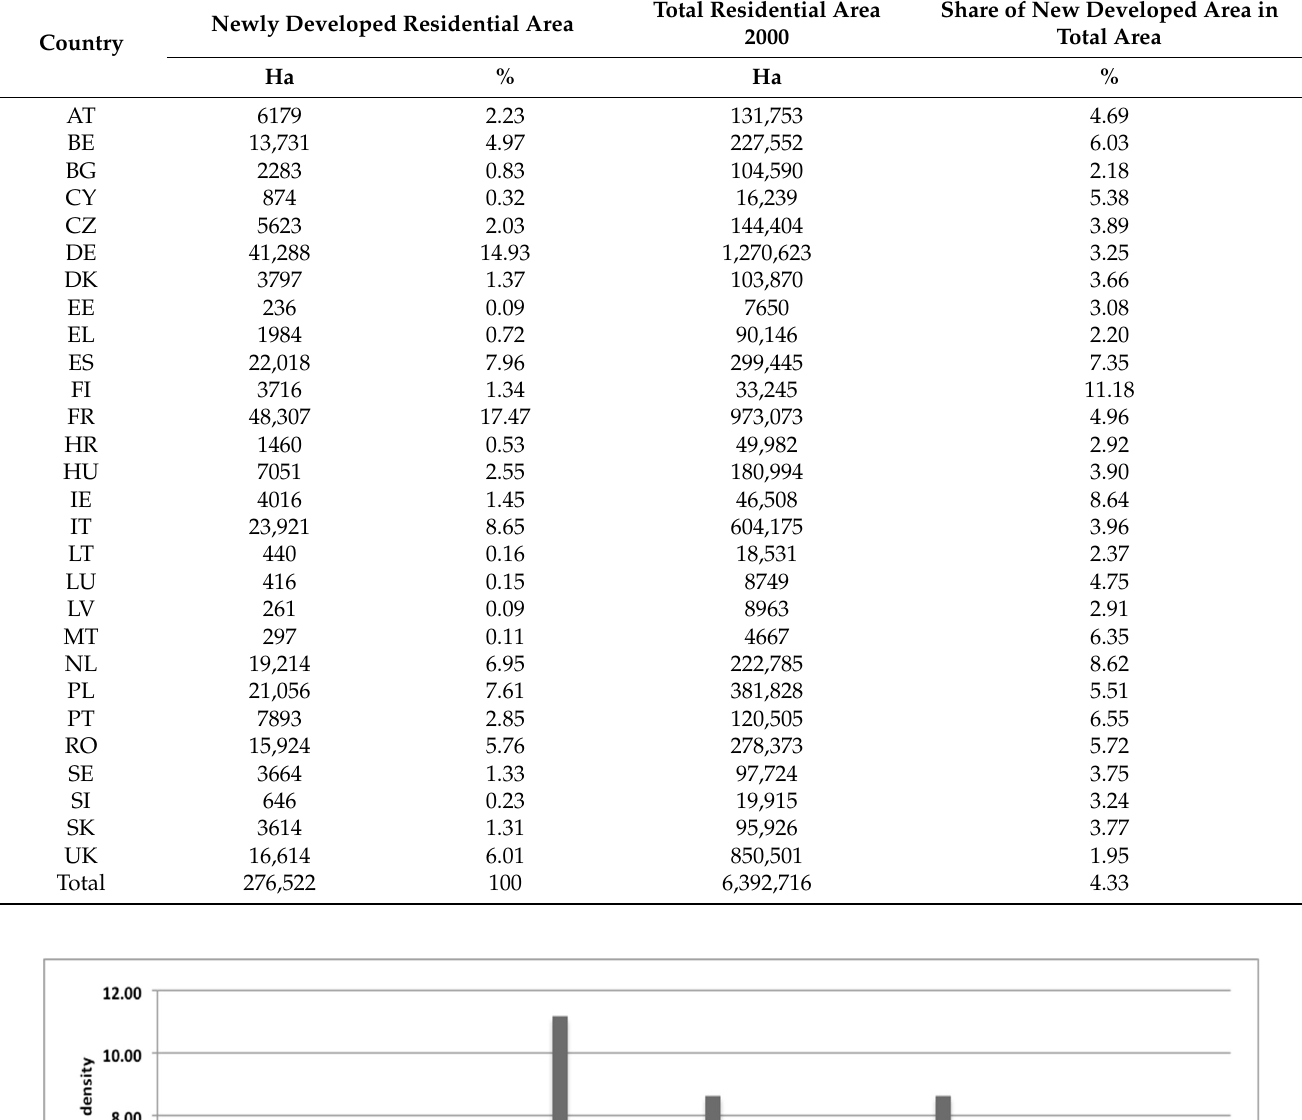
Table 2. Distribution of residential areas developed between 2000 and 2010 across countries in the EU.